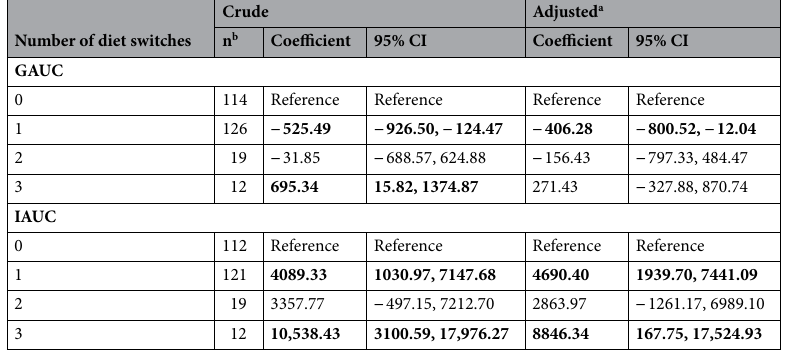
Table 6. Association of prior diet switches with third-trimester GAUC and IAUC (n = 273). CI, confidence interval; GAUC, glucose tolerance test area under the curve; IAUC, insulin area under the curve. a Adjusting for age and parity. b Sample size differs from 273 due to missing GAUC or IAUC measurements. The bold indicates significantly different values from the reference